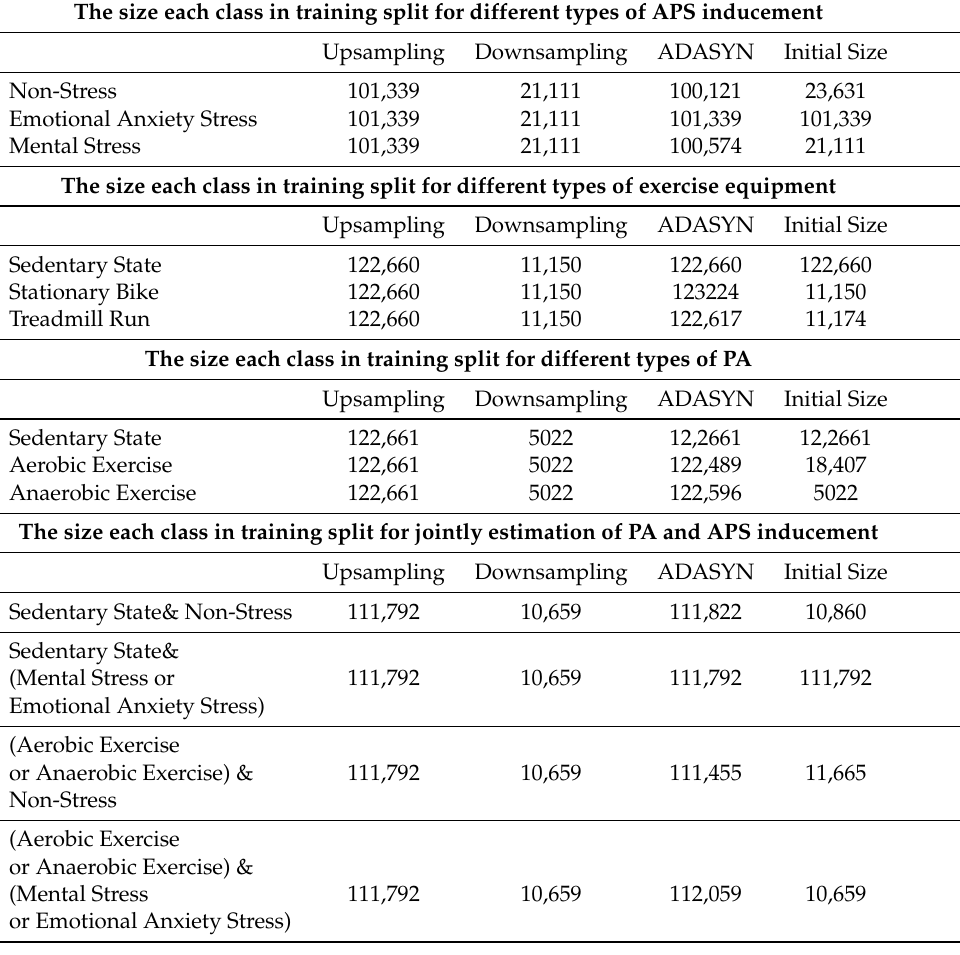
Table 4. The size of the training splits after applying different techniques for balancing the training split of the